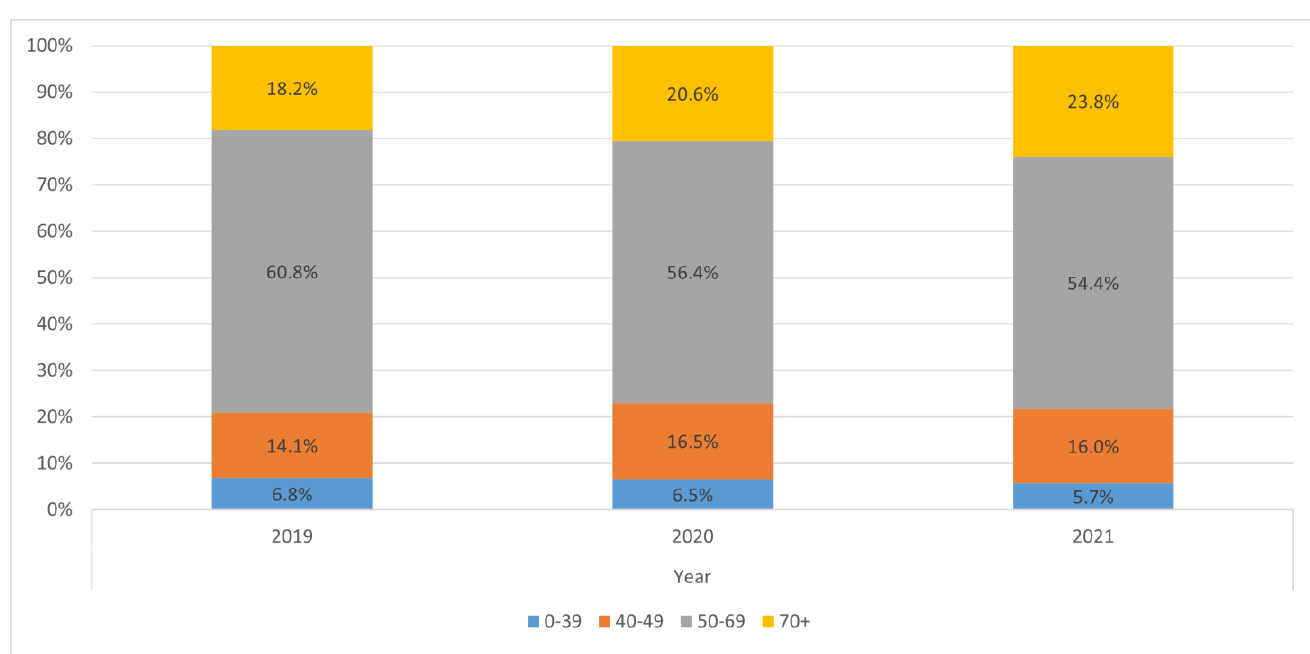
Figure 1. Age group structure of the staged BC cases in years 2019 – 2021.